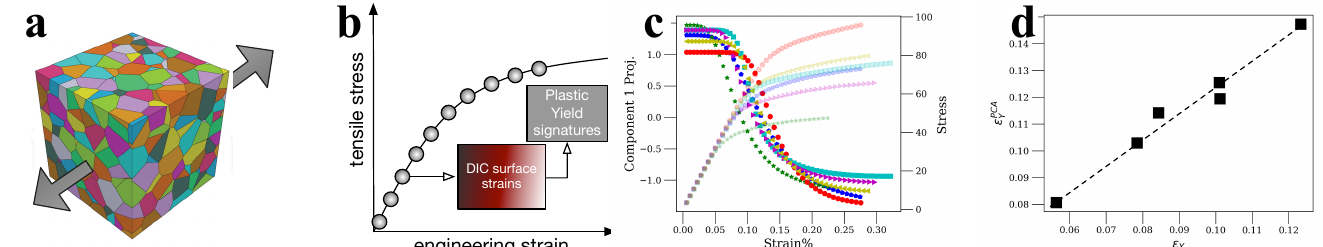
Figure 7. DIC and materials informatics for yield strength prediction in polycrystalline metals. ( a ) DIC on the top surface of a polycrystalline metal, studied through crystal plasticity simulations. ( b ) Strain map information acquired in situ can be processed to uncover yielding information, not accessible through common measures, ( c ) Unsupervised machine learning (PCA), in Ref. [60], a transition signature was identified in component projections, ( d ) yield point prediction through the proposed method, provides a very accurate alternative to common engineering ways by just studying stress-strain curves. Adopted from Ref. [60] with permissions from American Physical